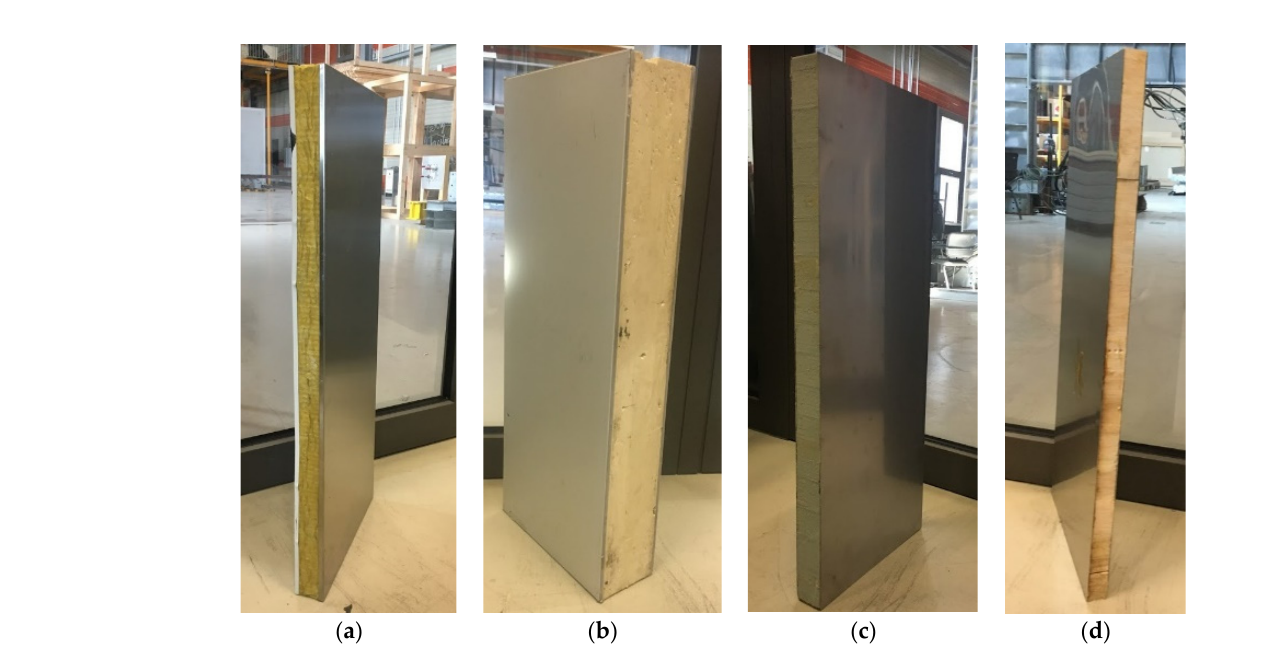
Figure 1. Photographic record of the test specimens: ( a ) MW core; ( b ) PUR core; ( c ) PET core; ( d ) balsa wood core.